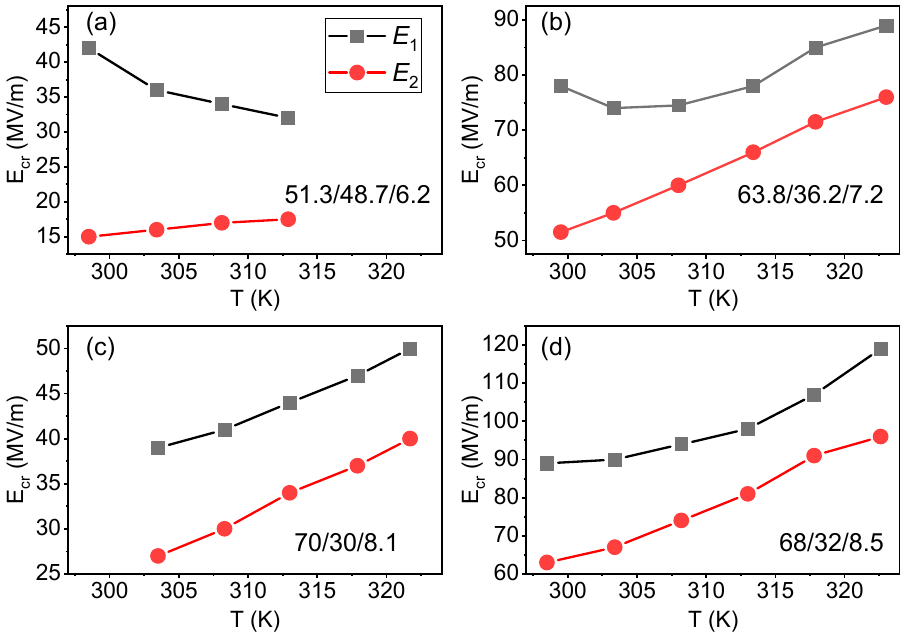
Figure 5. Temperature dependences of the critical fields, E 1 and E 2 , corresponding to the field- induced transitions between relaxor and ferroelectric states for the P(VDF-TrFE-CFE) 51.3/48.7/6.2 ( a ), 63.8/36.2/7.2 ( b ), 70/30/8.1 ( c ), and 68/32/8.5 ( d ) polymer films.